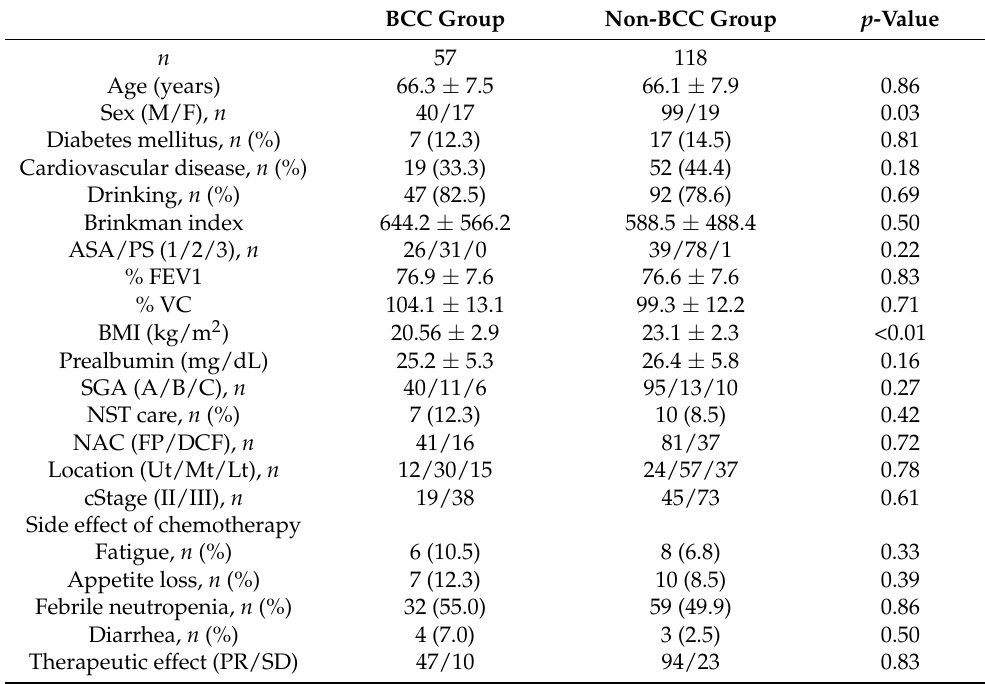
Table 3. Characteristics of BCC group.